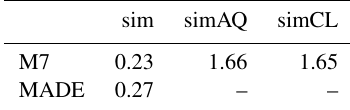
Table 7. SO 4 surface concentrations in µgm − 3 for simulations ac- cording to Table 4. Values are horizontal averages over continental Europe. sim simAQ simCL M7 0.23 1.66 1.65 MADE 0.27